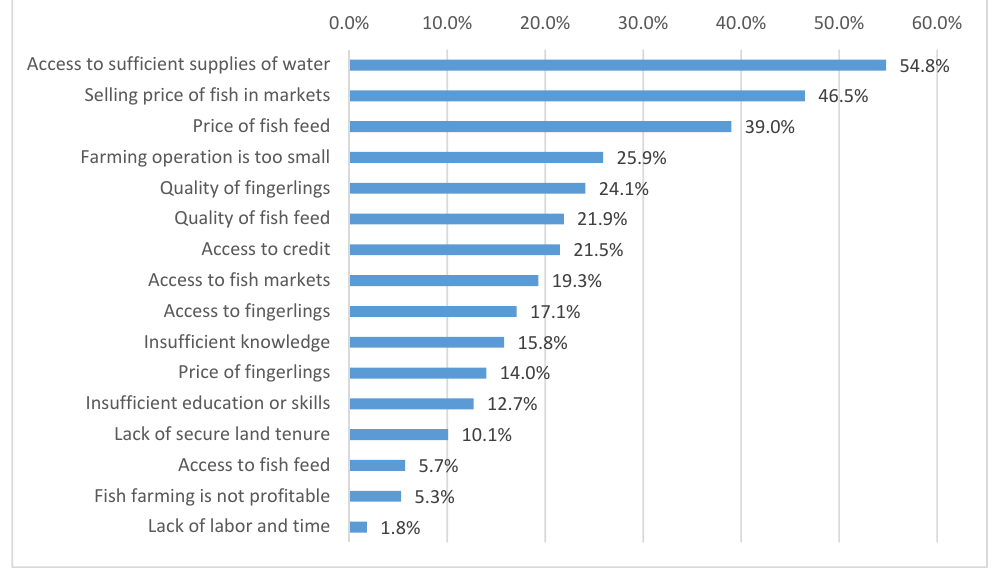
Figure 2. Barriers to adoption of improved farming practices or technologies ( n = 228).